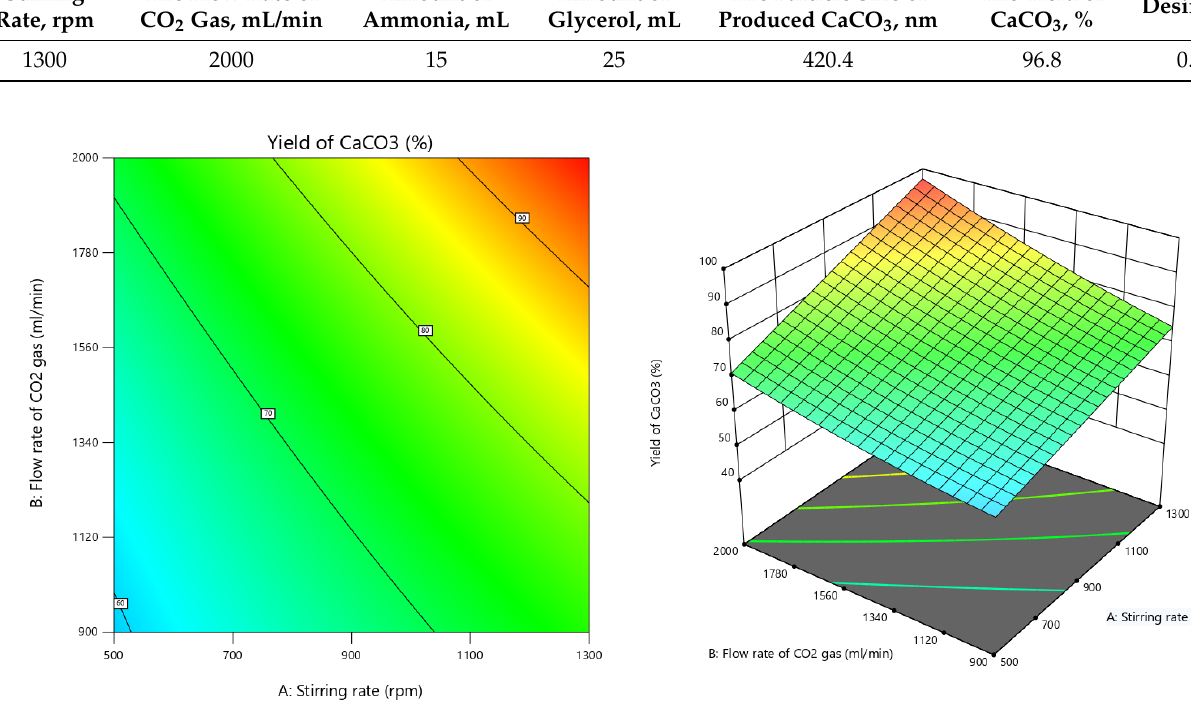
Figure 17. Relationship between the CO 2 flow rate, stirring rate, and the yield of CaCO 3 (Contour and 3D plot).